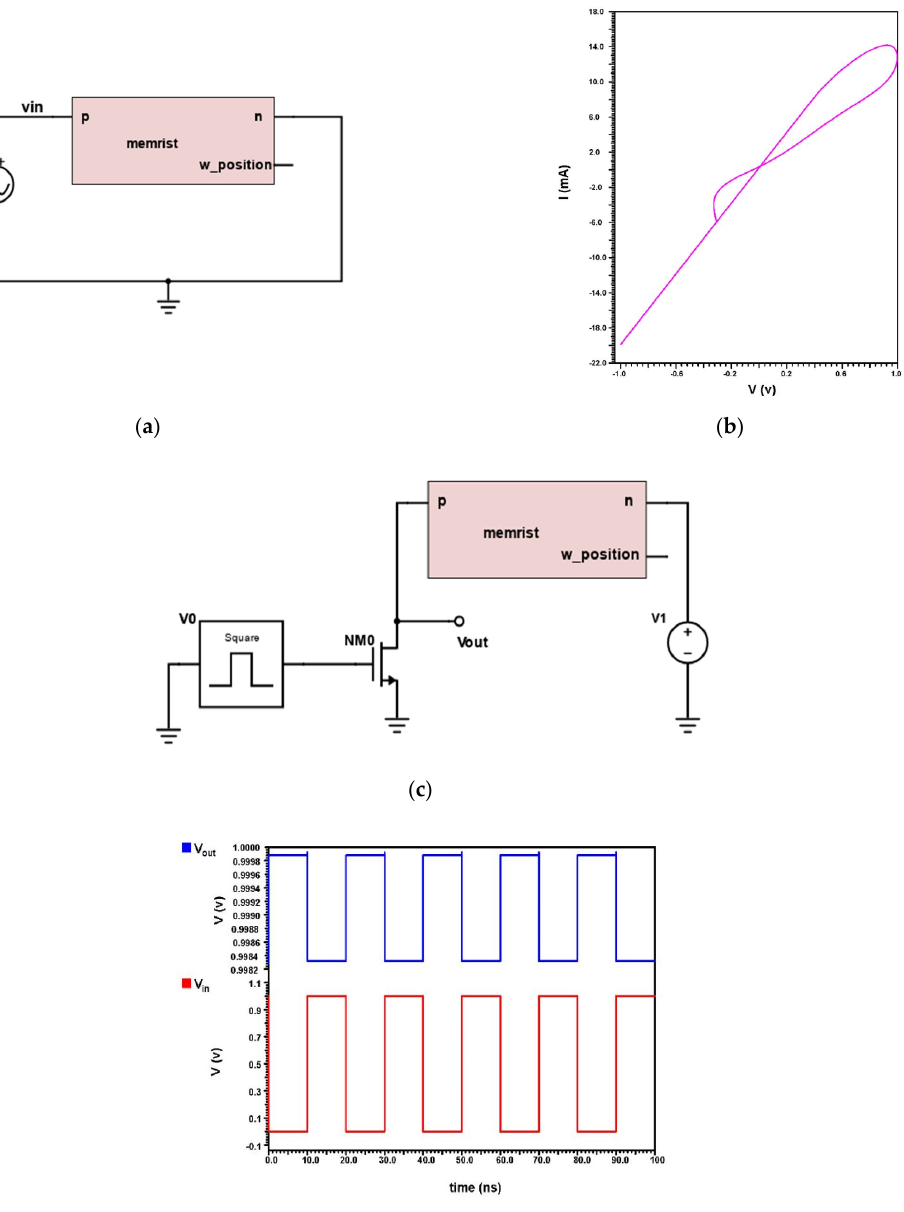
Figure 9. ( a ) Ti/TiN based Memristor schematic and its ( b ) I ‐ V Characteristics, ( c ) Schematic of Memristor–MOS Transistor based Inverter and its ( d ) Transient Analysis . Memristor–MOS Transistor based Inverter and its ( d ) Transient